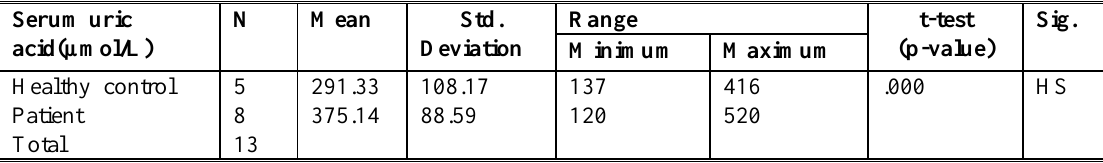
Table 4: Mean distribution of Uric acid concentration of studied groups. Serum